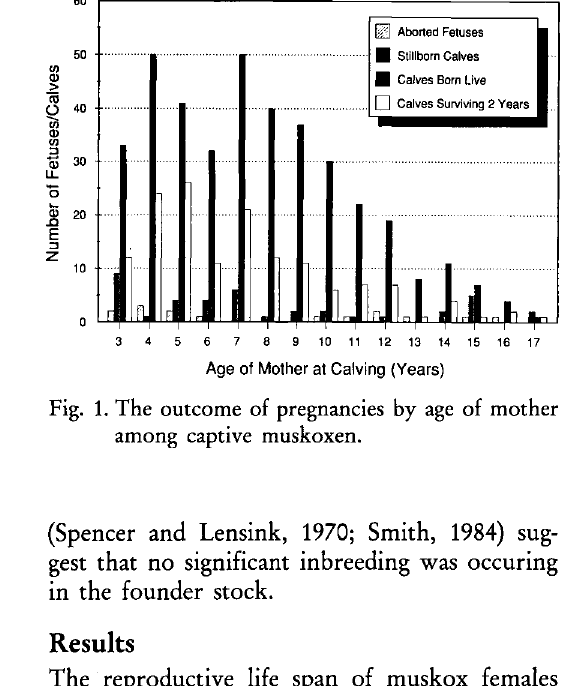
1. The outcome of pregnancies by age of mother among captive muskoxen.